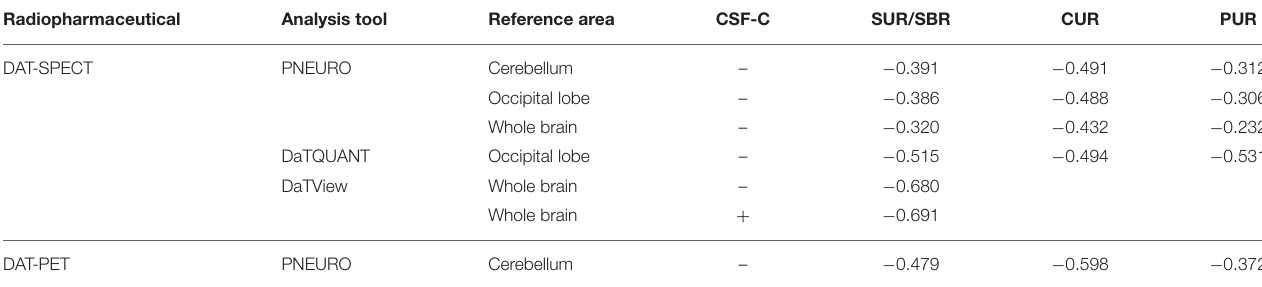
TABLE 2B | Annual decline rate of DAT activity for Age, measured with DAT-SPECT and DAT-PET.